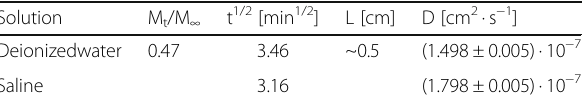
Table 1 Results of diffusion coefficient calculations Solution